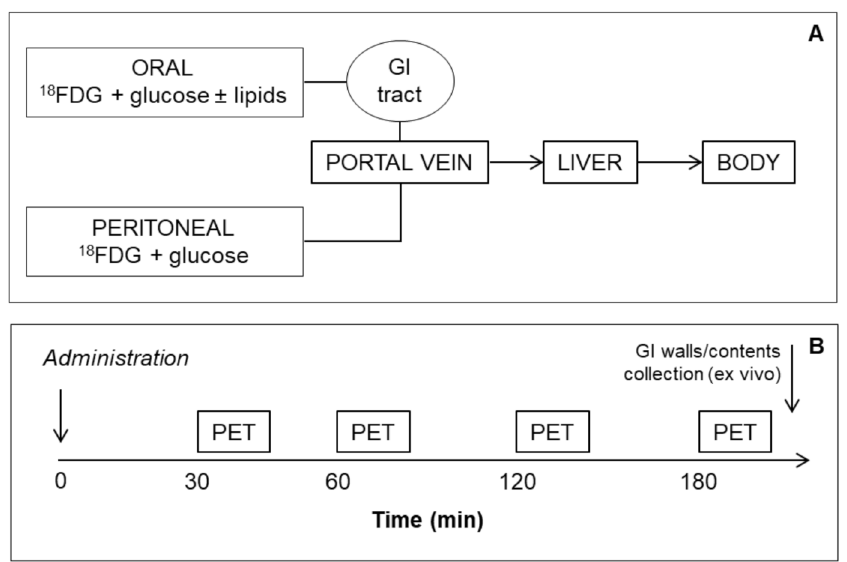
Figure 1. Study design: The design ( A ) involved different types of 18 FDG and glucose delivery to either by-pass the GI wall (i.p.), or transit across the GI wall (oral glucose, with and without the addition of oral lipids). Panel ( B ) shows the imaging sequence of 4 PET scans, followed by animal sacrifice, activity counting of GI walls and/or GI contents and histological examinations of liver, duodenum, and